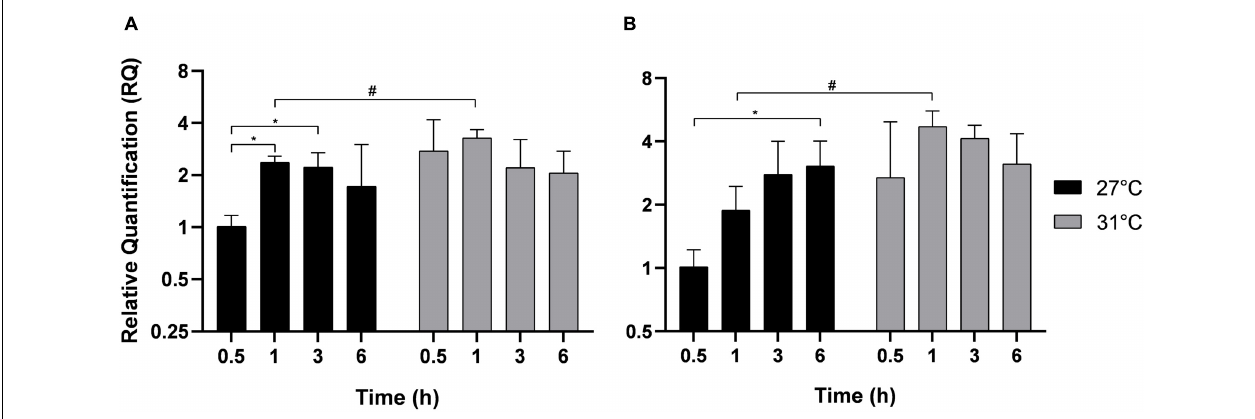
FIGURE 5 | Thermostable direct hemolysin gene expression in free-living V. parahaemolyticus (A) and adherent bacteria (B) incubated at 27 ◦ C (black) and 31 ◦ C (gray). Bacteria were maintained 0.5, 1, 3, and 6 h in different conditions before RNA extraction from free-living bacteria and adherent bacteria in same well. Relative quantification expressions are expressed as means ± standard deviations of results from experiments performed with three replicate samples. # Significant difference between temperatures. *Significant difference between time